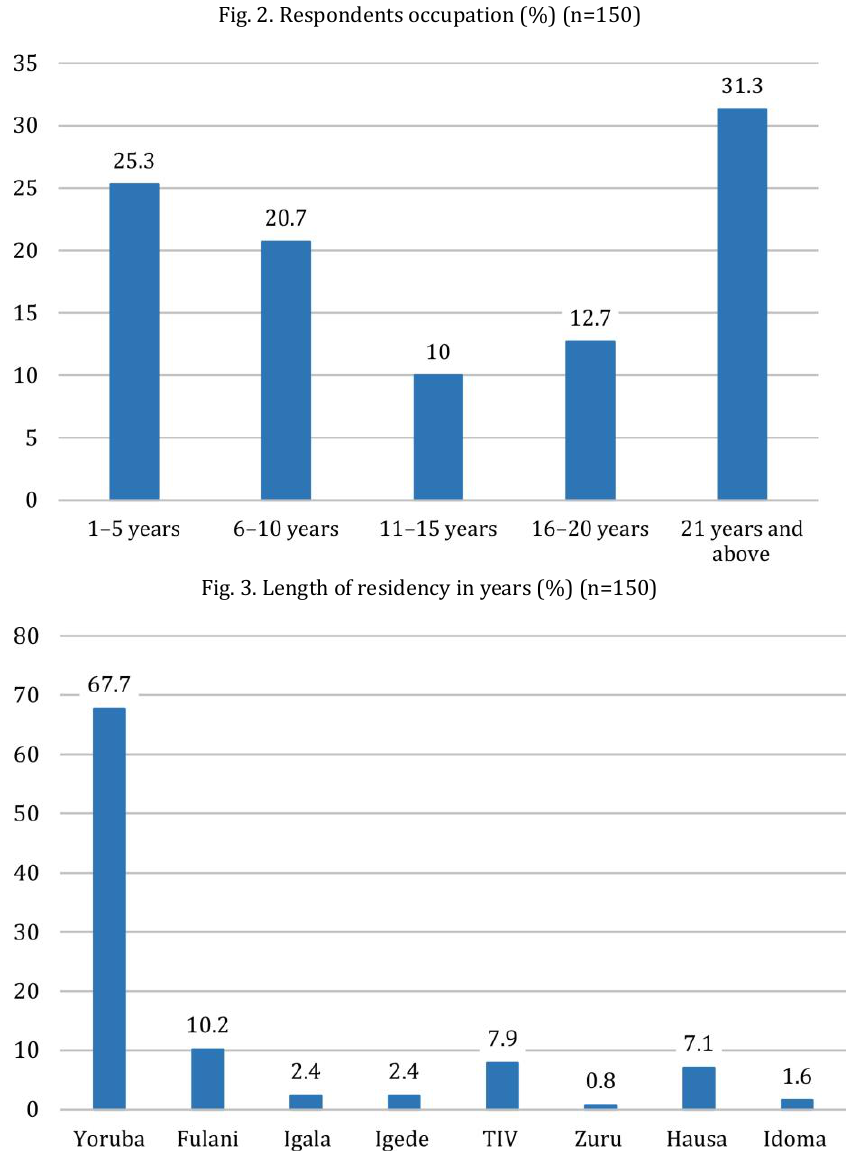
Fig. 4. Distribution of respondents according to their ethnic groups (%)